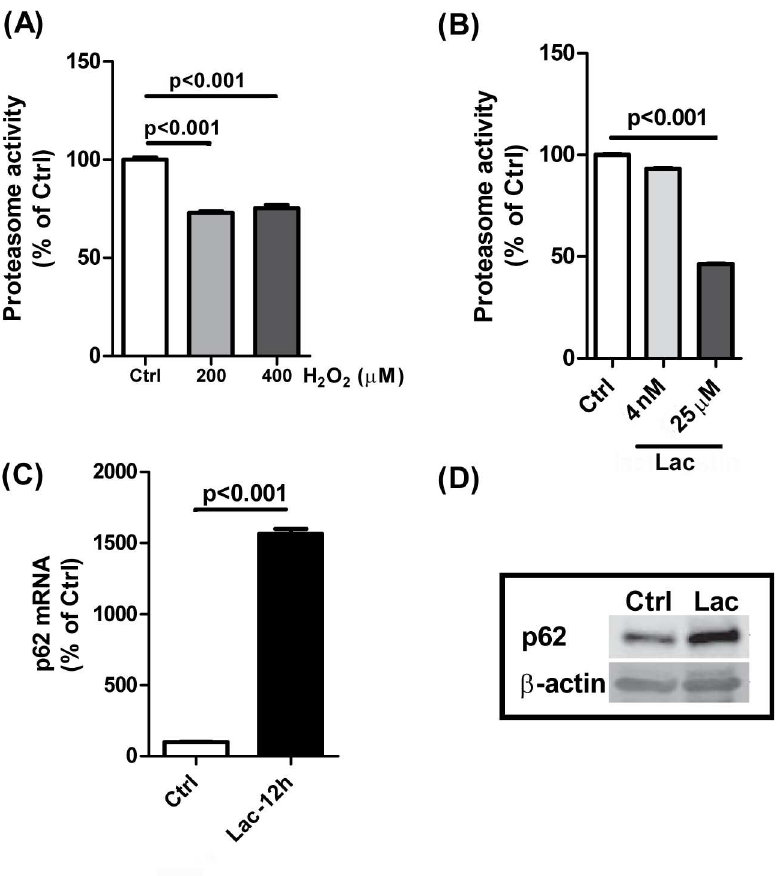
Fig 3. H 2 O 2 inhibits proteasome activity and proteasome inhibitor lactacystin induces p62 up- regulation. (A) ARPE-19 cells weretreated with 200or 400 μ MH 2 O 2 and then chymotrypsin-likeproteasome activity was measuredat 24h post-exposure usinga fluorogenic substrate. Control (Ctrl) = No H 2 O 2 (B) Chymotrypsin-likeproteasomeactivity was detected in RPE cells treated with the proteasome